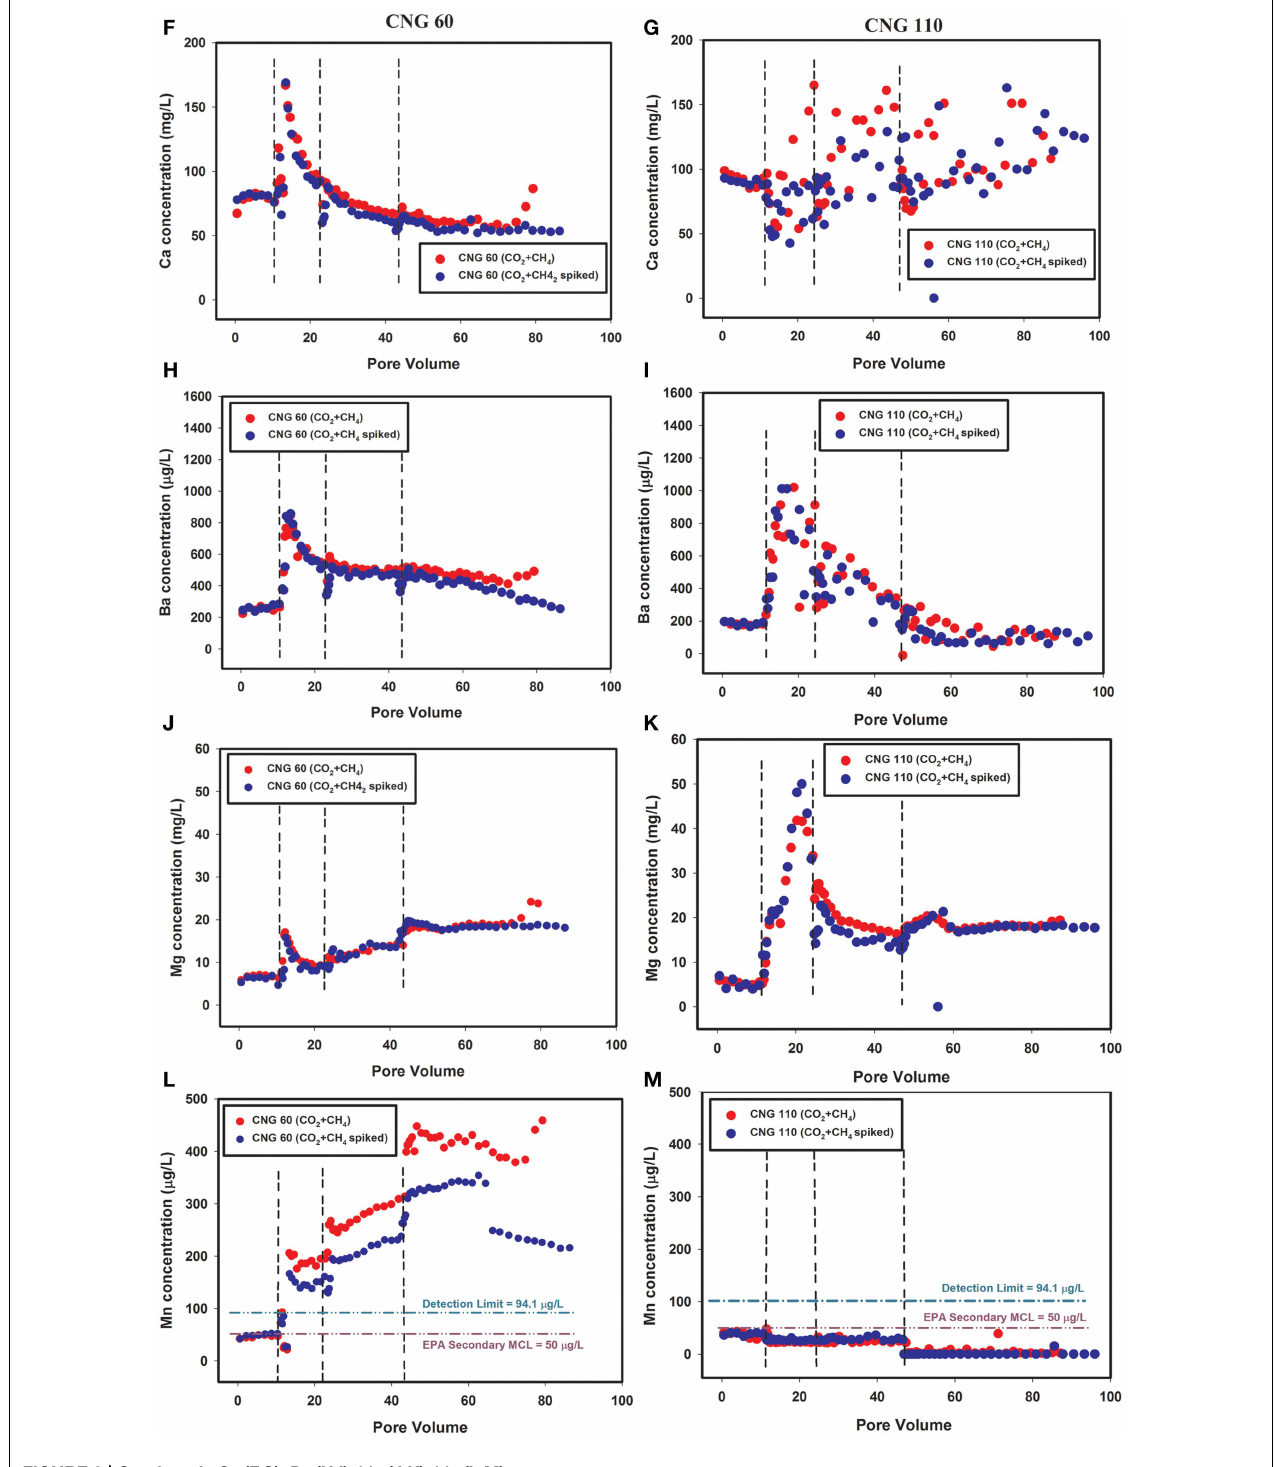
FIGURE 3 | Continued: Ca (F,G) , Ba (H,I) , Mg (J,K) , Mn (L,M)